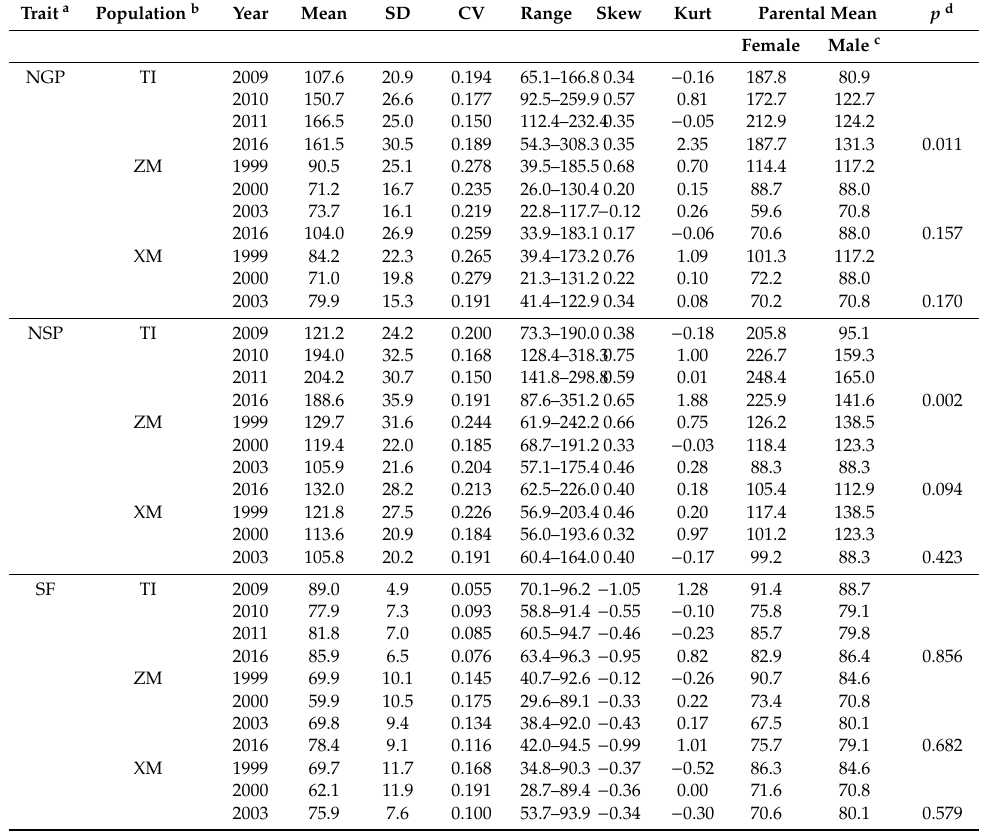
Table 1. Phenotypic performance of number of grains per panicle (NGP), number of spikelets per panicle (NSP) and spikelet fertility (SF) in the three recombinant inbred line (RIL) populations. Trait a Population